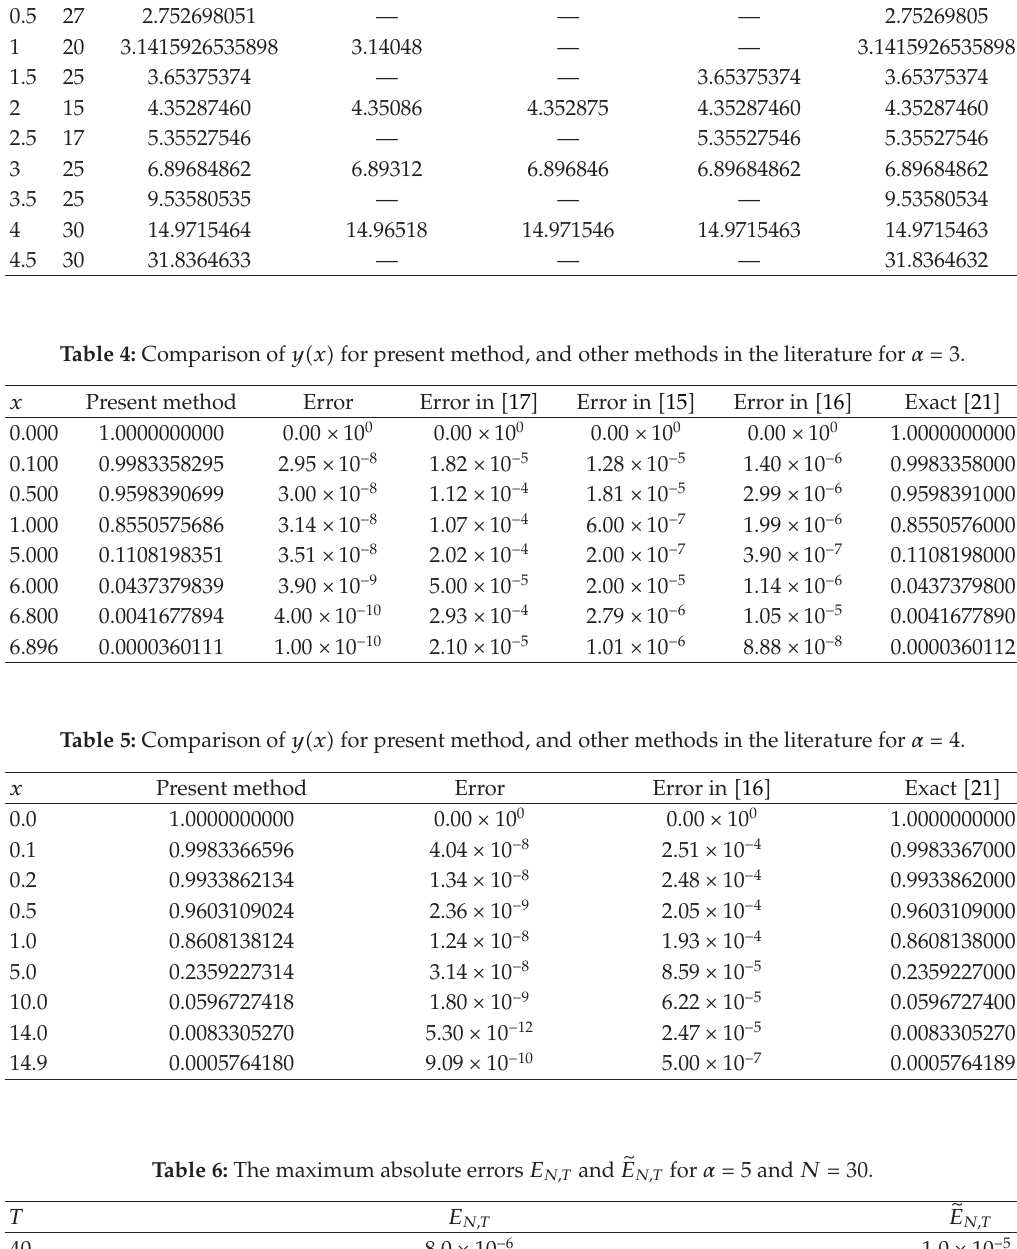
Table 6: The maximum absolute errors E N,T and